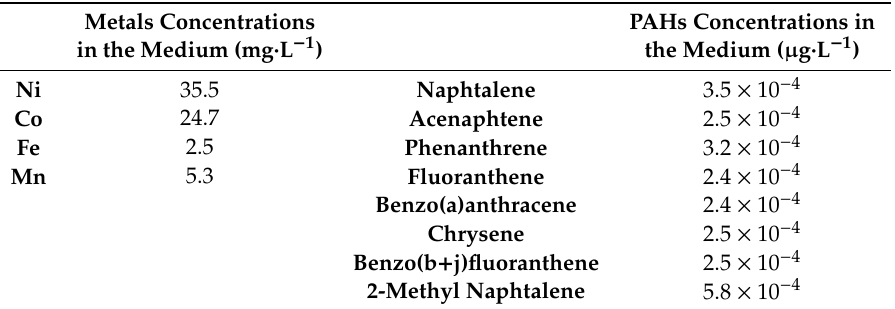
Table 3. Concentration of metals (Ni: nickel; Co: cobalt; Fe: iron; Mn: manganese) and polycyclic aromatic hydrocarbons (PAHs) released in the exposure medium at 10 mg · L − 1 of GO. Among the 32 analyzed PAHs, only those with a concentration over the detection limit are